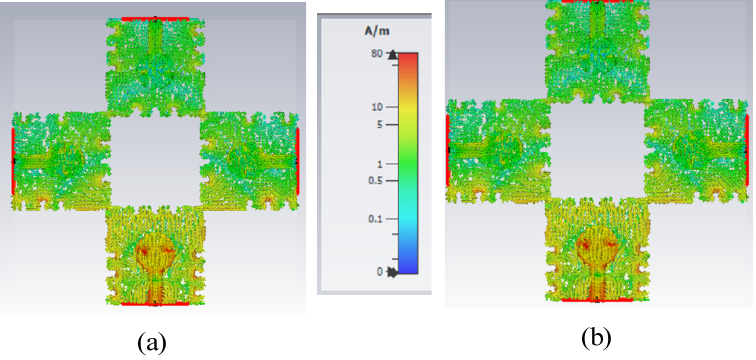
Figure 11. Surface Current distribution of proposed MIMO antenna at ( a ) 27 GHz ( b ) 28 GHz.